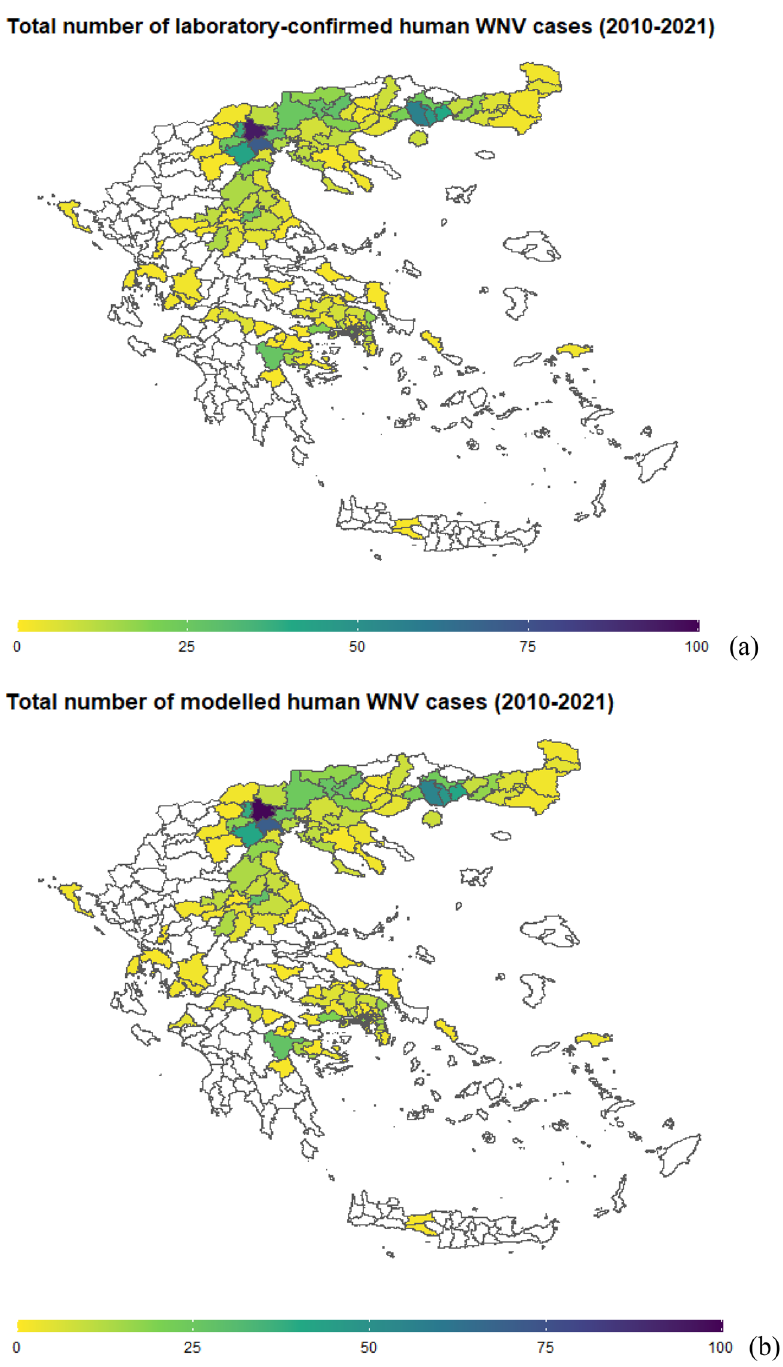
Figure 1. ( a ) Map of Greece with total numbers of laboratory-confirmed human WNV cases throughout the 12-year period 2010–2021, with breakdowns by municipality. White denotes municipalities where no human cases were observed. ( b ) Map of Greece with total numbers of modelled human WNV cases throughout the 12-year period 2010–2021, with breakdowns by municipality. White denotes municipalities where no human cases were